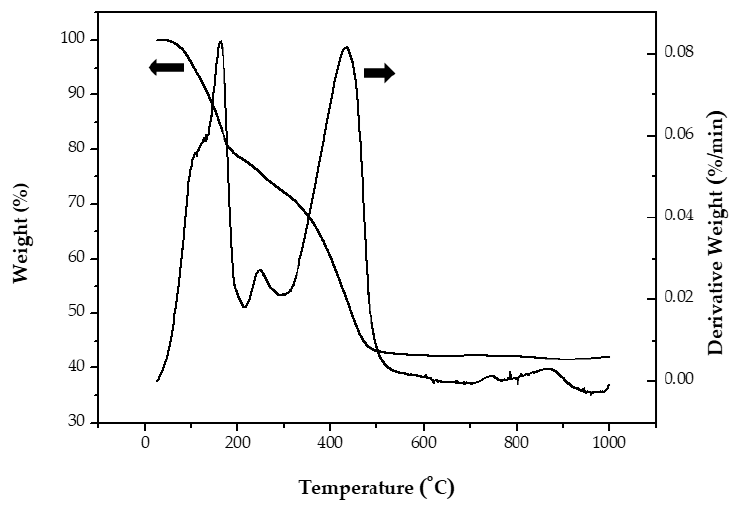
Figure 1. Thermogravimetric analysis (TGA) and derivative thermogravimetry (DTG) of oil-containing sludge at 10 °C/min under nitrogen flow.